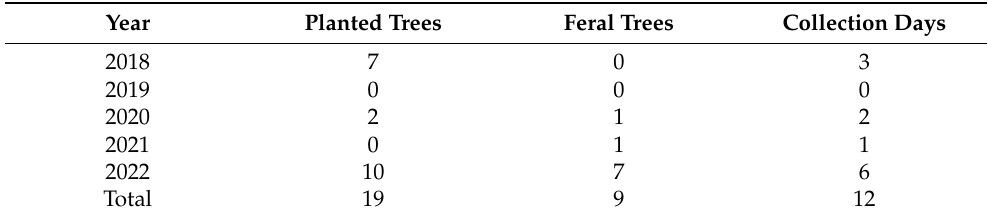
Table 1. Number of P. calleryana sampled each year and the number of days with specified weather conditions for sampling during the bloom period. Year Planted Trees Feral Trees Collection Days 2018 7 0 3 2019 0 0 0 2020 2 1 2 2021 0 1 1 2022 10 7 6 Total 19 9